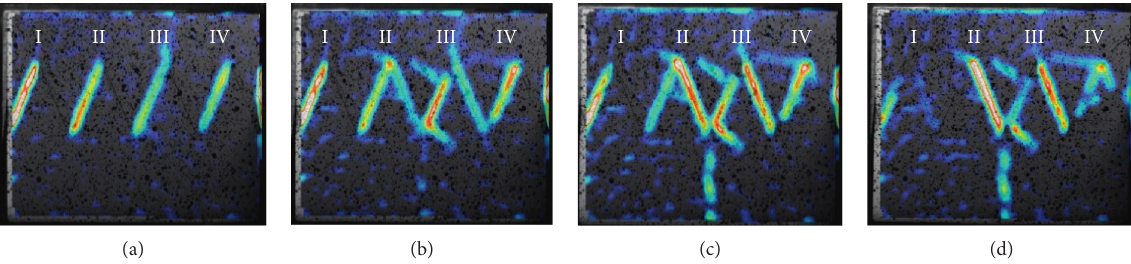
Figure 16: Typical development process of shear failure of jointed specimens